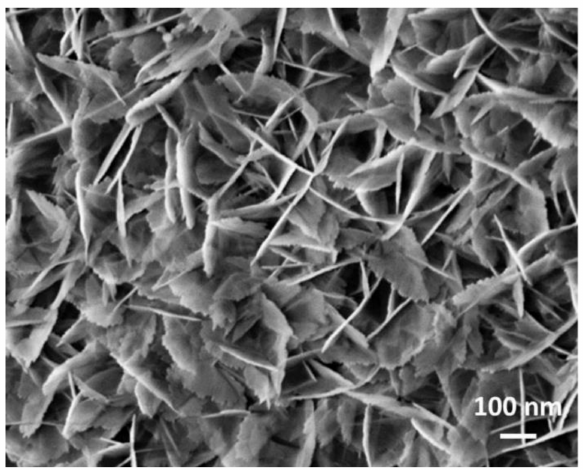
Figure 4. Micrograph of nanostructured Al 2 O 3 inorganic layer.